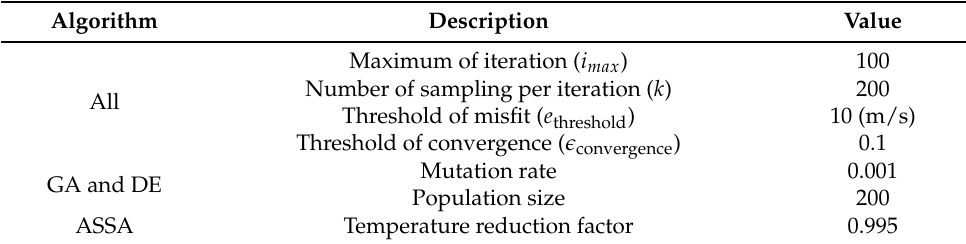
Table 3. Preset parameters of the candidate